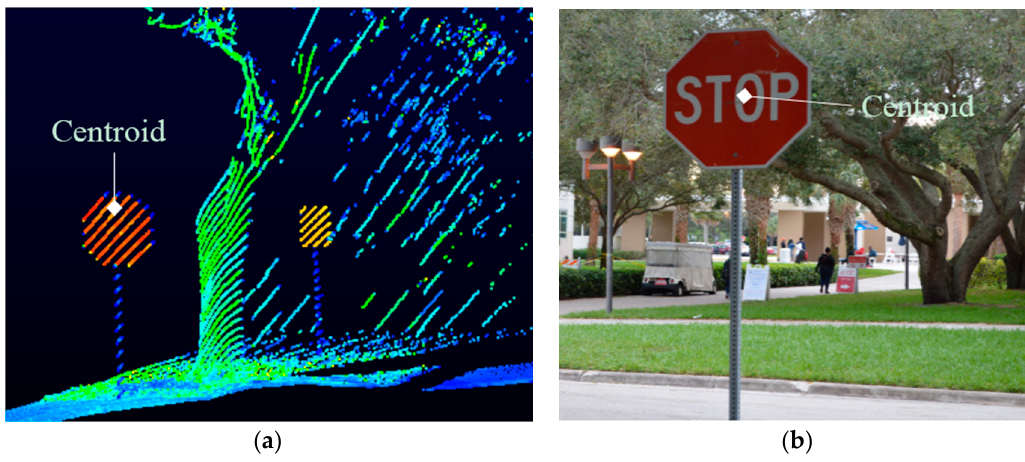
Figure 5. Extraction of road signs from Lidar point clouds and images. ( a ) Points from point cloud whose intensity >100 (high reflectance of aluminum); height from curb > 5 ft.; dimension between 0.4 m and 1.6 m; ( b ) Locating the signboard on the image using the coordinate of its centroid